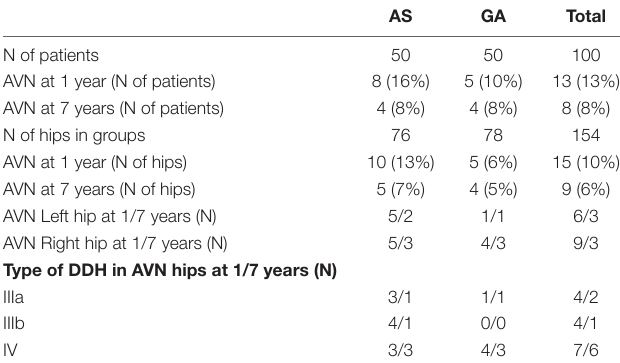
TABLE 2 | Outcome characteristics of